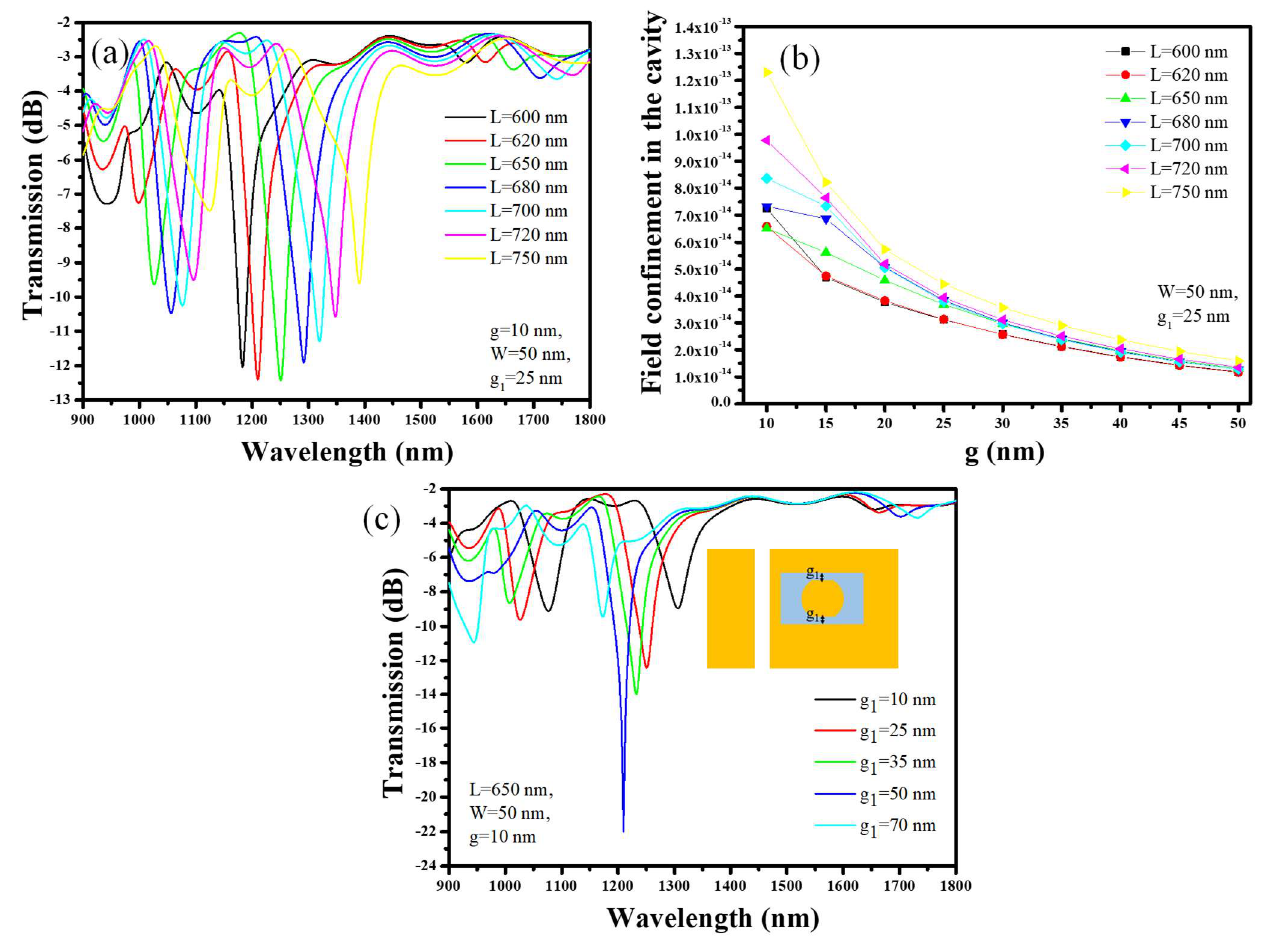
Figure 2. Device optimization: ( a ) Transmission vs. L, ( b ) Field confinement in the cavity versus g, ( c ) Transmission versus g 1 .